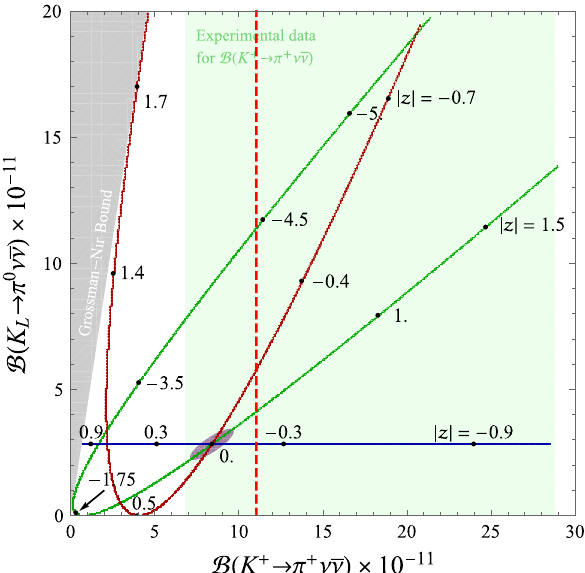
Fig. 1 New physics with lepton flavour conserving left-handed neutri- nos. The green line illustrates the case X N real, the red line corresponds to X N having a phase equal to that of the λ t (central value) and the blue line to X N having a phase equal to minus that of the λ t . For comparison the purple marks the SM 1 σ region and the green marks the 90% c.l. from BNL-787 combined with BNL-949. Finally the vertical dashed red line marks a possible future limit for B K + at 1.3 times the SM